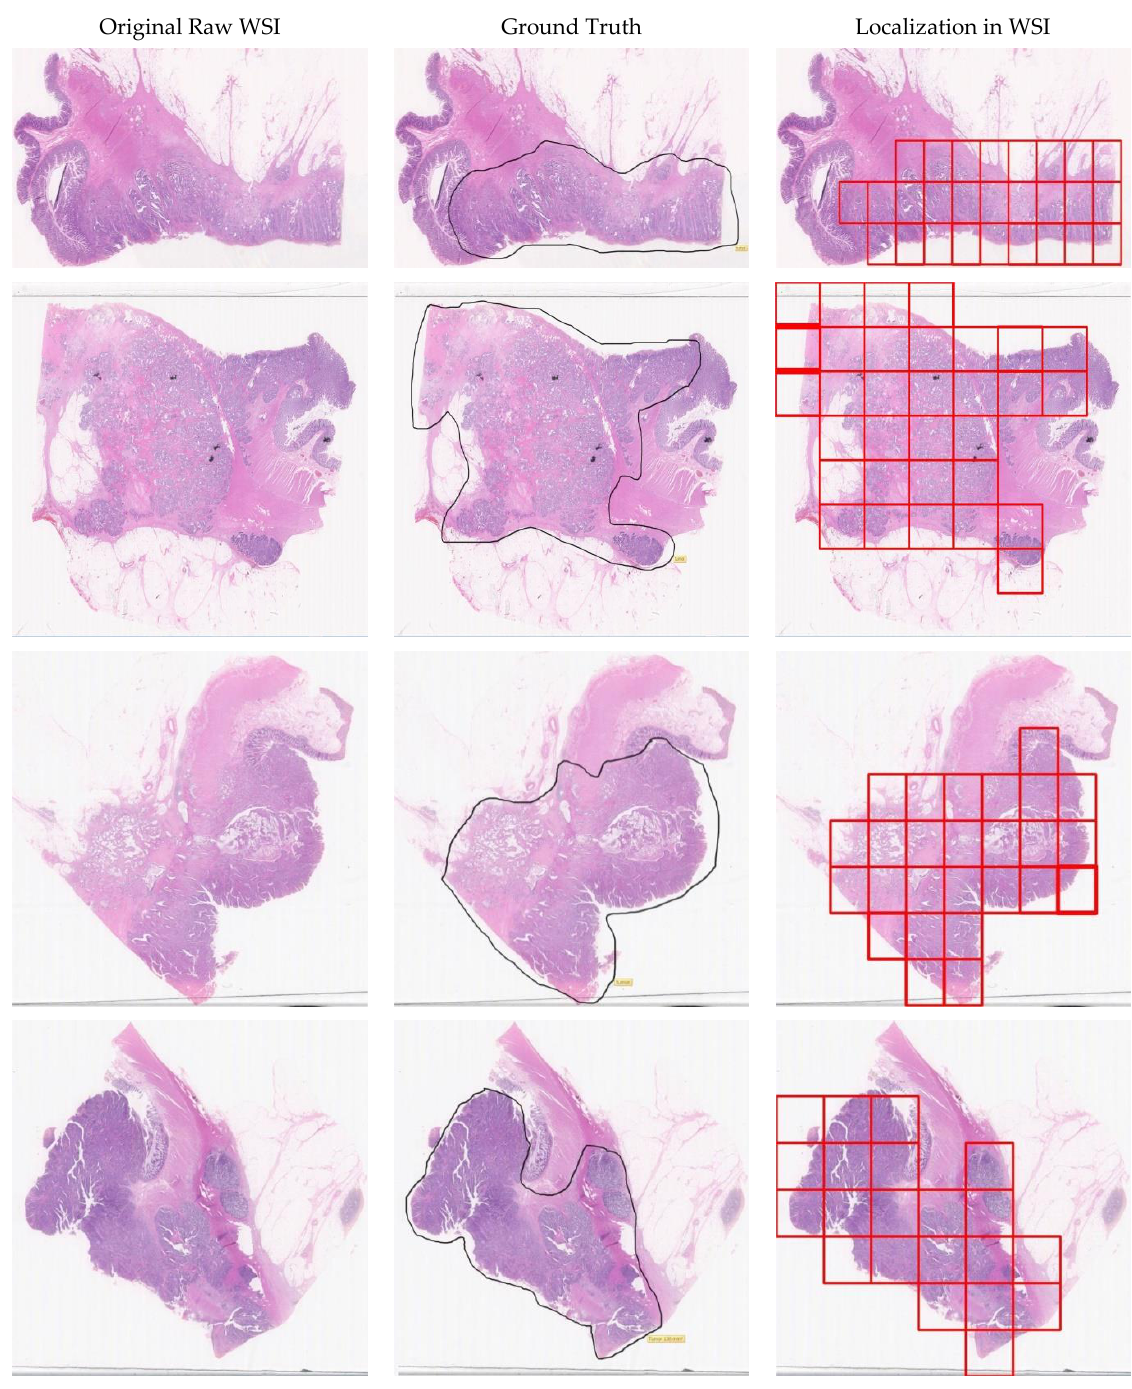
Figure 10. Comparison of ground truths vs. the outputs produced by IR-v2 Type 5: column 1: original WSIs; column 2: corresponding ground truths; column 3: corresponding output for abnormal tissues localized in WSIs.